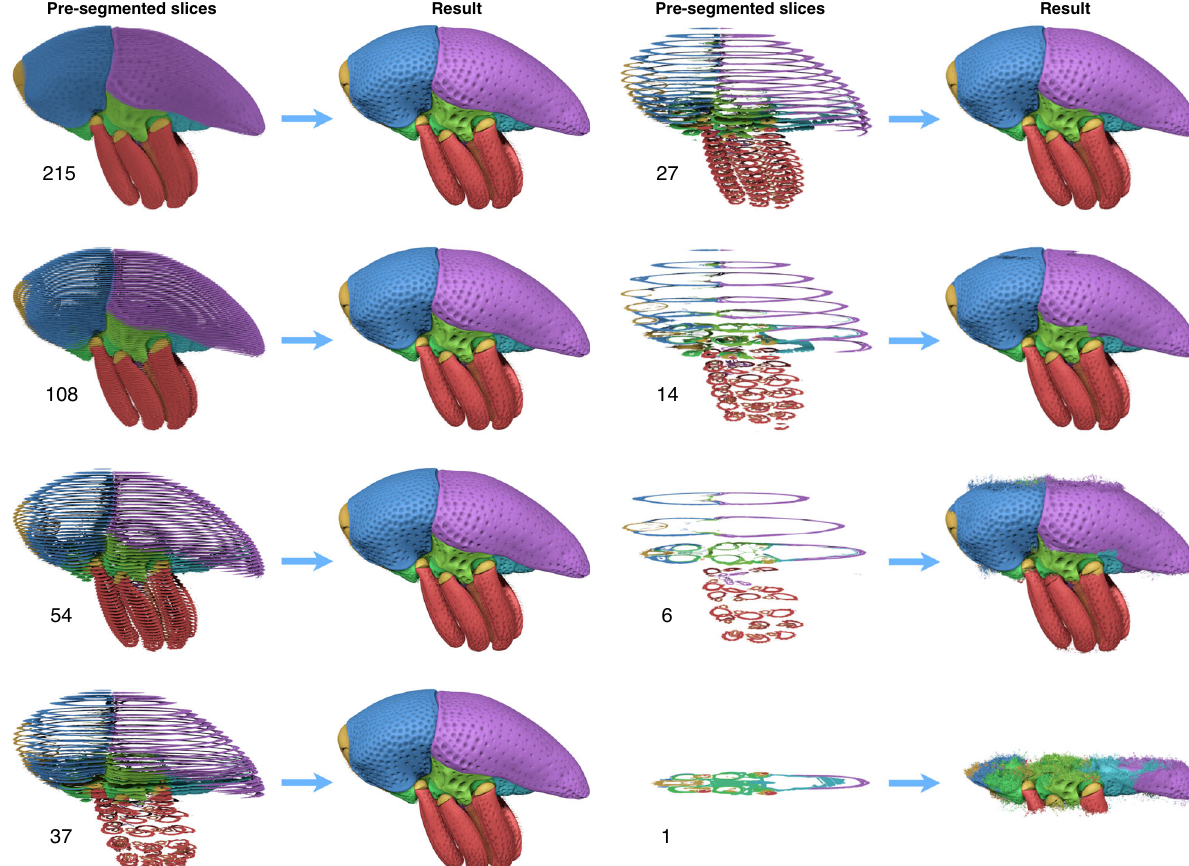
Fig. 3 Biomedisa results based on different numbers of pre-segmented slices. Inputs of 215 (as used for morphological interpolation), 108 and 54 equally spaced slices that correspond to pre-segmentation of every 5th, 10th and 20th slice provided accurate results. By adapting the spacing between the slices to the weevil ’ s morphology, a much lower count of only 37 slices yielded a dataset of equal quality. Lower numbers of pre-segmented slices resulted in increasingly fl awed